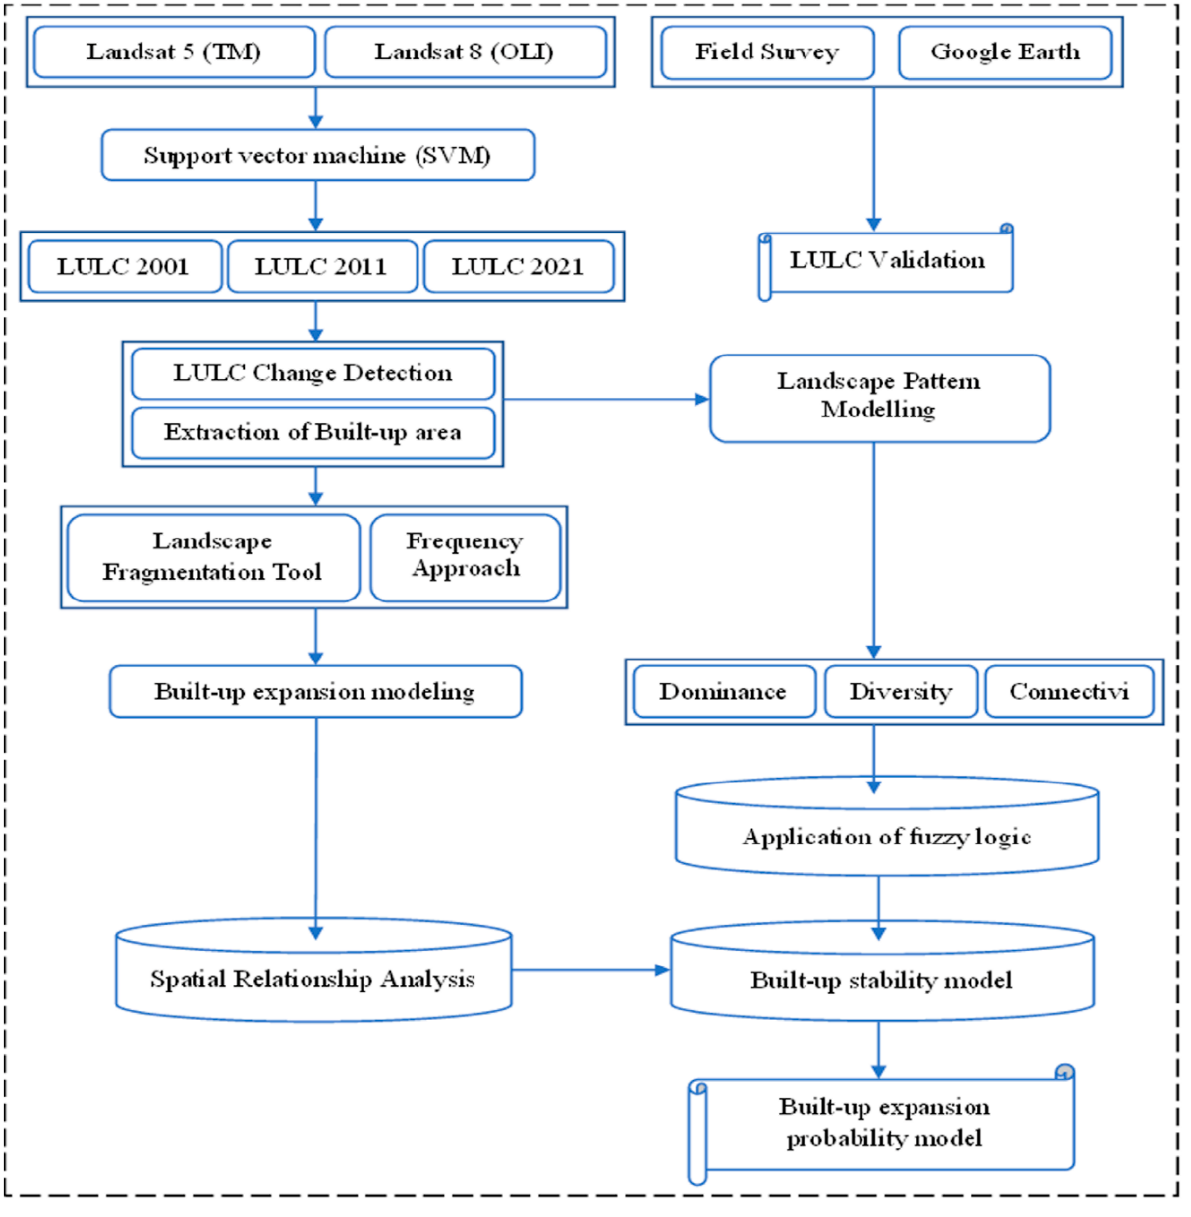
Figure 2. Hierarchical structure of the methodological framework of the entire study.